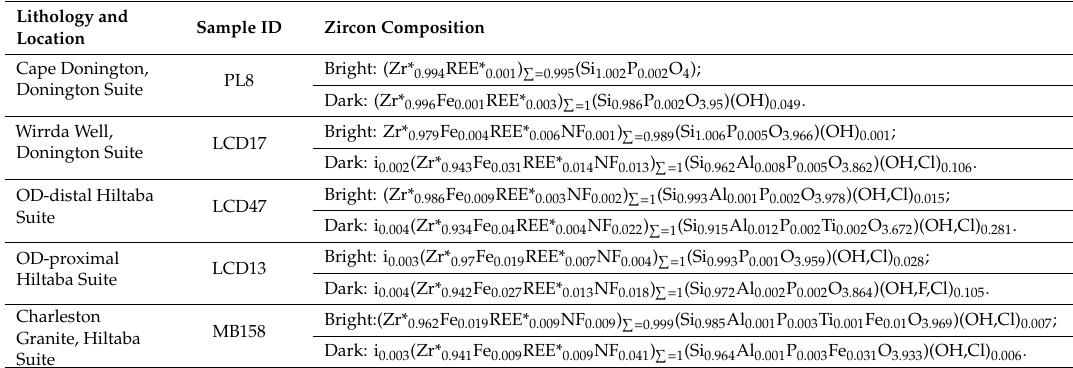
Table 3. Mean zircon compositions in bright and dark bands in each studied sample. Lithology and